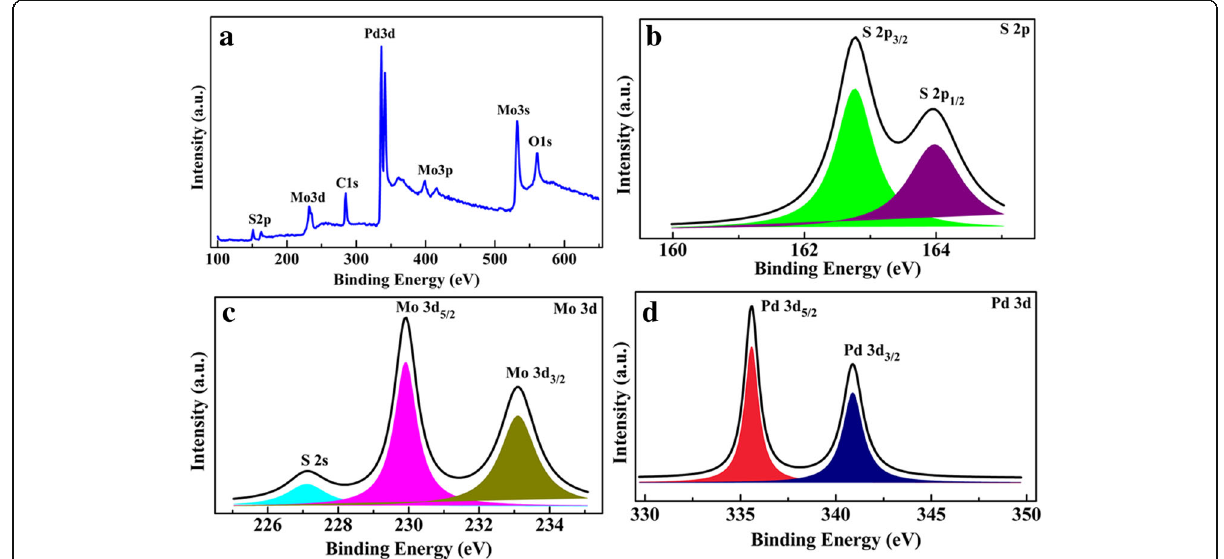
Fig. 1 a XPS survey, b S 2p, c Mo 3d, and d Pd 3d core level spectra of the 5-nm Pd-decorated MoS 2 layers on Si